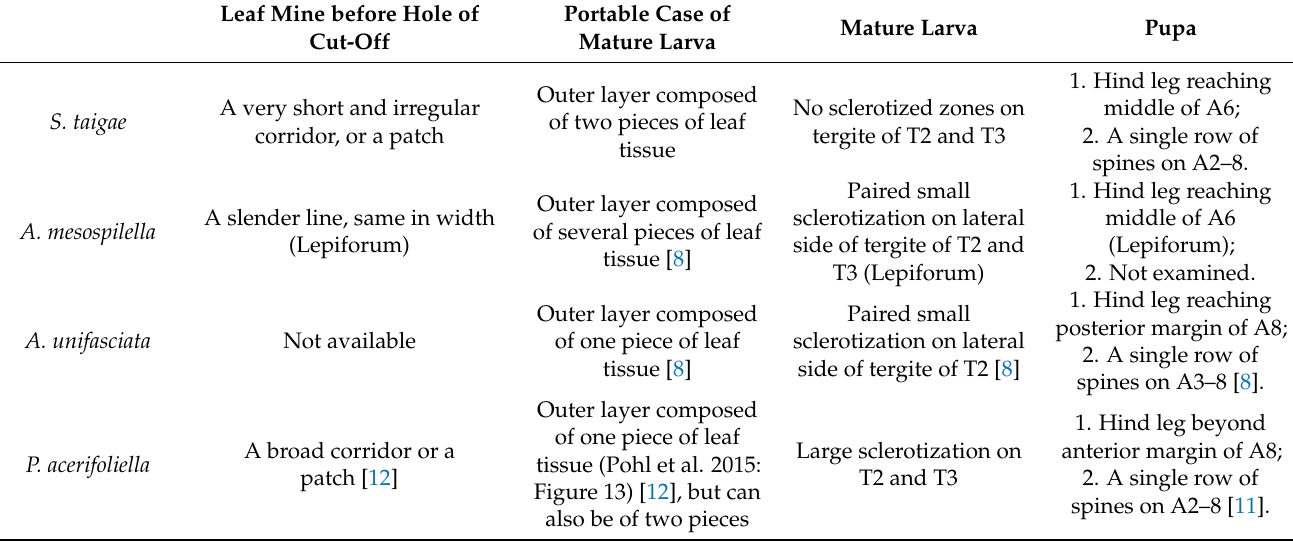
Table 2. Diagnosis of immature stages of species in related